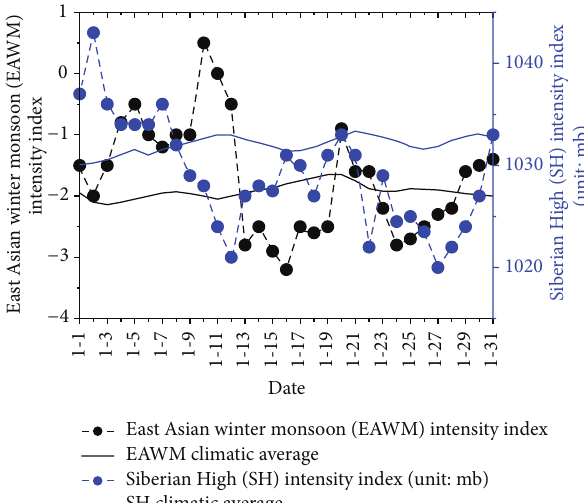
Figure 5: Time series of EAWM intensity index and SH intensity index, along with their climatic